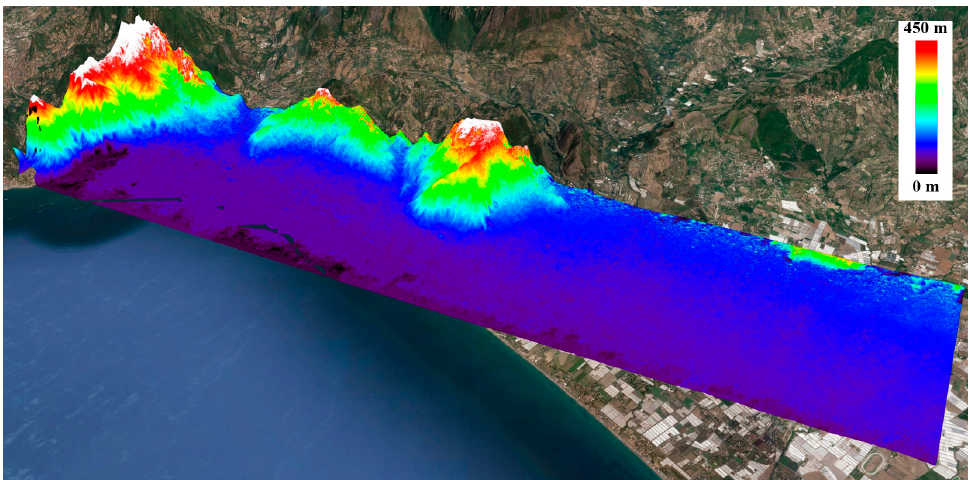
Figure 12. InSAR DEM obtained starting from the low-resolution interferogram considered in Figure 10a.